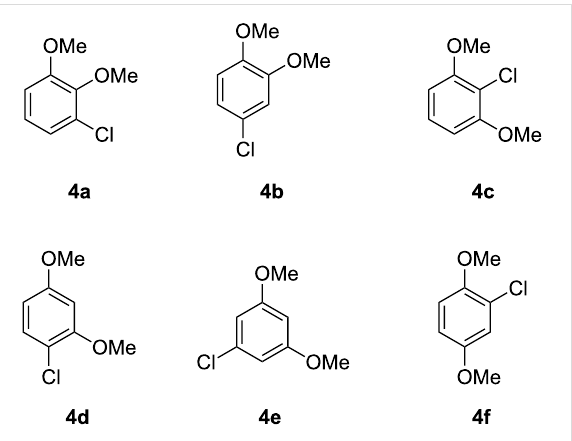
summarised in Table 2. Mass spectra, 1 H and 13 C NMR